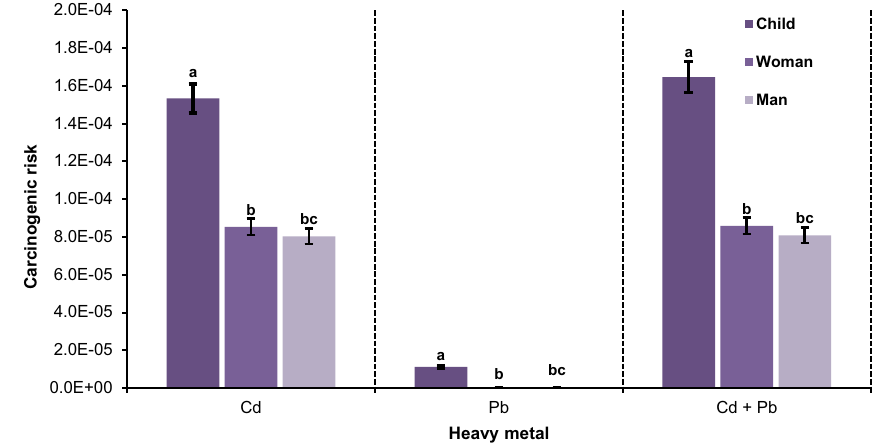
Figure 6. The comparison of the mean carcinogenic risk of Cd, Pb, and Cd + Pb among different population groups in urban soils. Different letters indicate significant differences among population groups in regard with each metal at P < 0.05 confidence